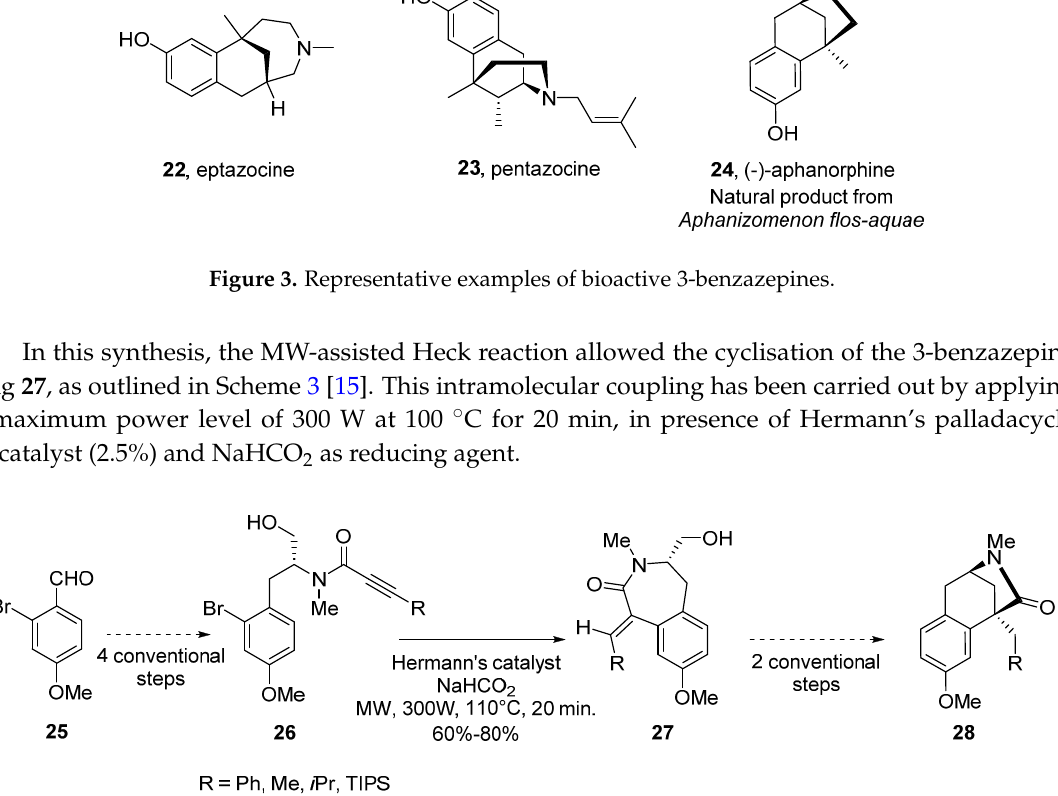
Figure 3. Representative examples of bioactive